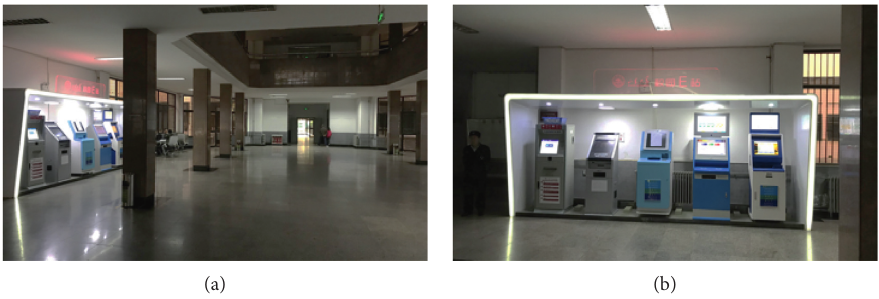
Figure 10: Environment of the lobby on the first floor. (a) The lobby on the 1st floor. (b) Self-service machine.